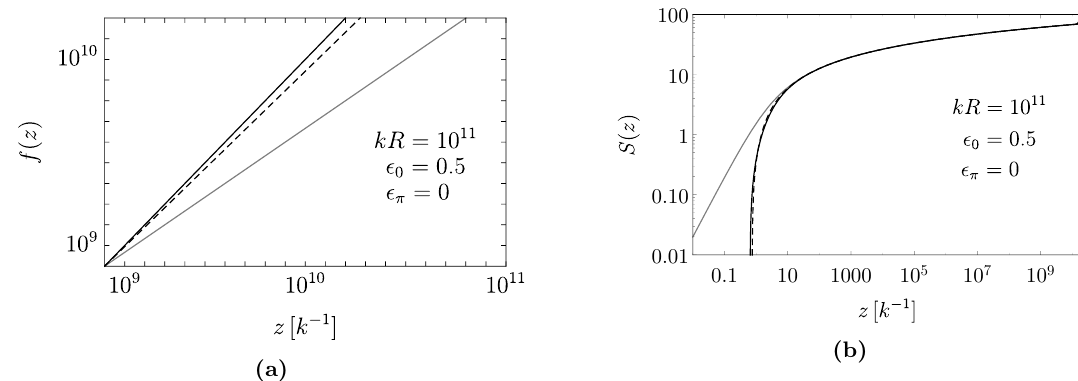
Figure 5. Metric warping (a) and Dilaton pro(cid:12)le (b) of the Linear Dilaton model with in(cid:13)ation in the case where the dilaton itself serves as a stabilizer. Next to our perturbative results (black) we also show a numerical solution (black, dashed) and the static case solution (gray). For the chosen parameters, the resulting Hubble rate is H (cid:25) 8 : 5 (cid:2) 10 (cid:0) 18 k (cid:25) 8 : 5 (cid:2) 10 (cid:0) 15 GeV corresponding to a reheating temperature around the electroweak scale (assuming maximally e(cid:14)cient reheating). The solution for the metric warping and dilaton pro(cid:12)le is fully speci(cid:12)ed by this. Note